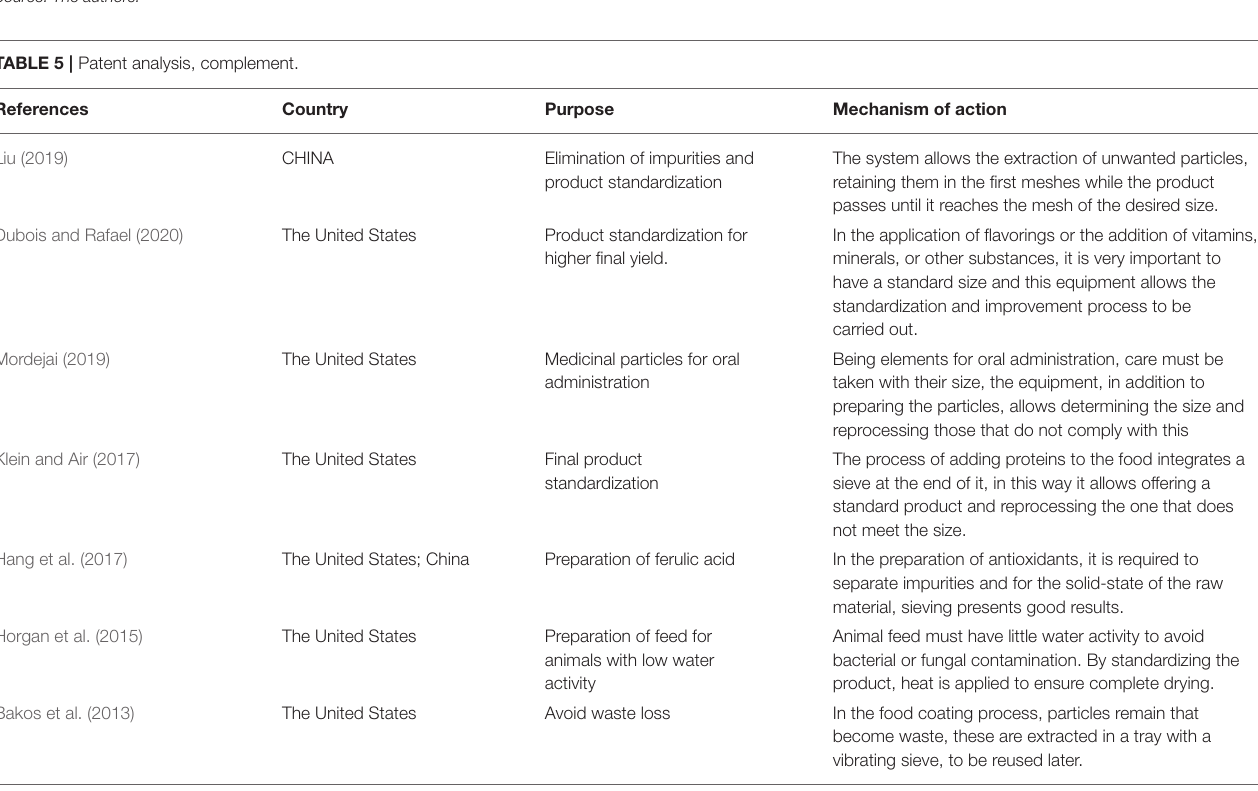
TABLE 5 | Patent analysis,